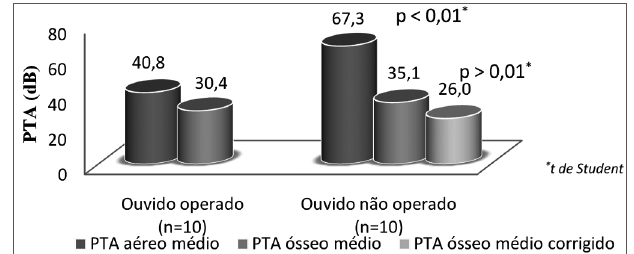
Figura 6. Comparação do PTA aéreo e ósseo dos doentes com otos - clerose bilateral e cirurgia estapédica unilateral. Comparação de